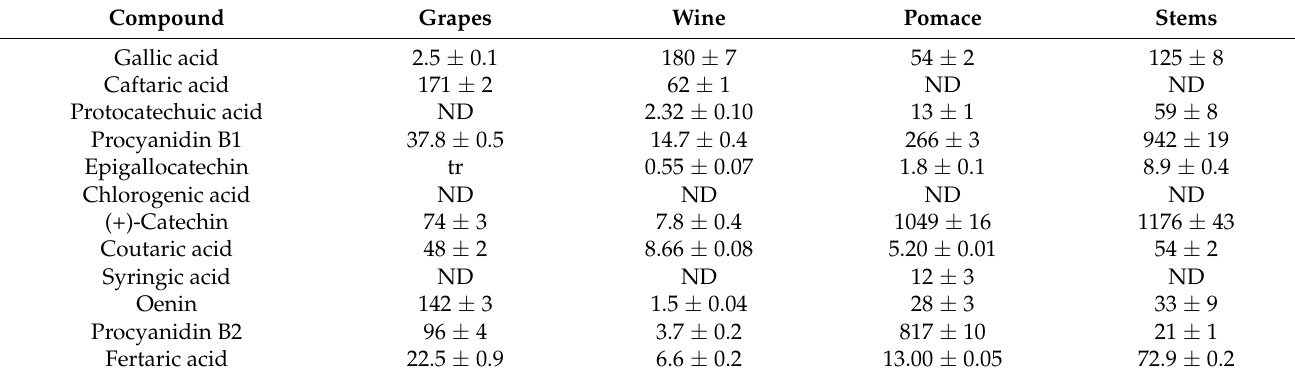
Table 5. Quantitation of phenolic compound content in the Mandilaria red variety (mg/kg DW) and wine (mg/L). Compound